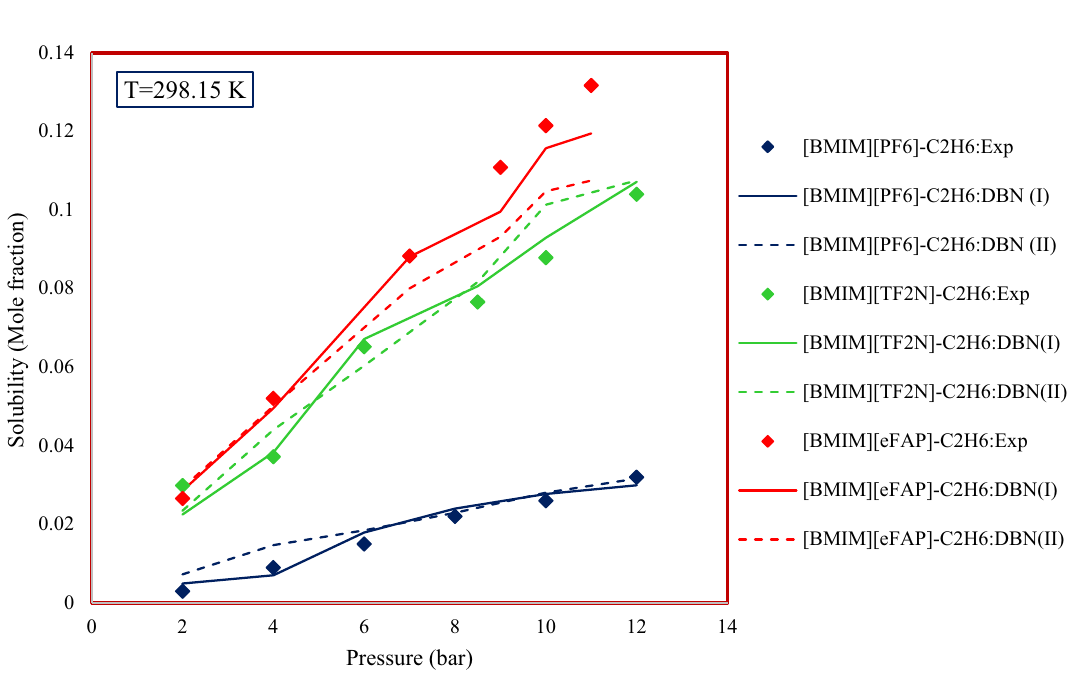
Figure 15. Pressure and anion type effect on the solubility of gaseous hydrocarbons in ionic